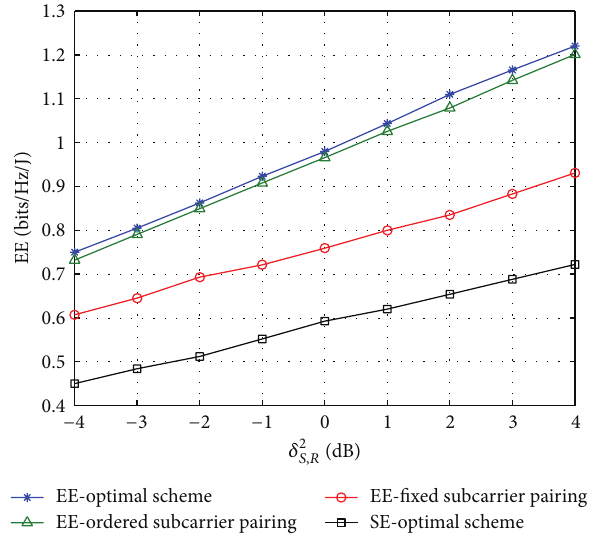
Figure 4: Energy efficiency versus channel variance of 𝑆 → 𝑅 link with 𝑁 = 12 relays, and 𝑤 1 = 𝑤 2 = 1 .